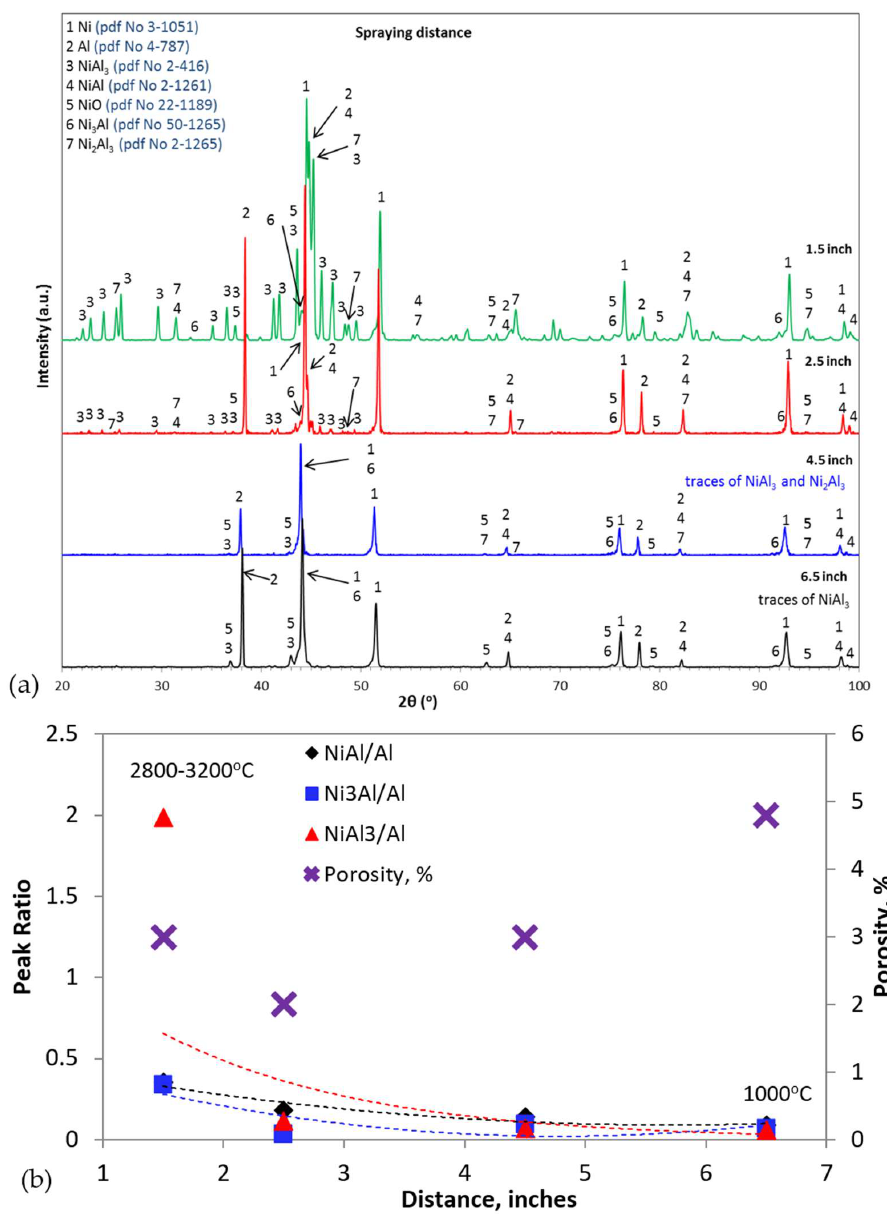
Figure 4. ( a ) XRD pattern of the surfaces formed after different thermal spraying distance and ( b ) coating porosity and semiquantitative analysis of the IC phases present in the coatings as functions of the thermal spraying